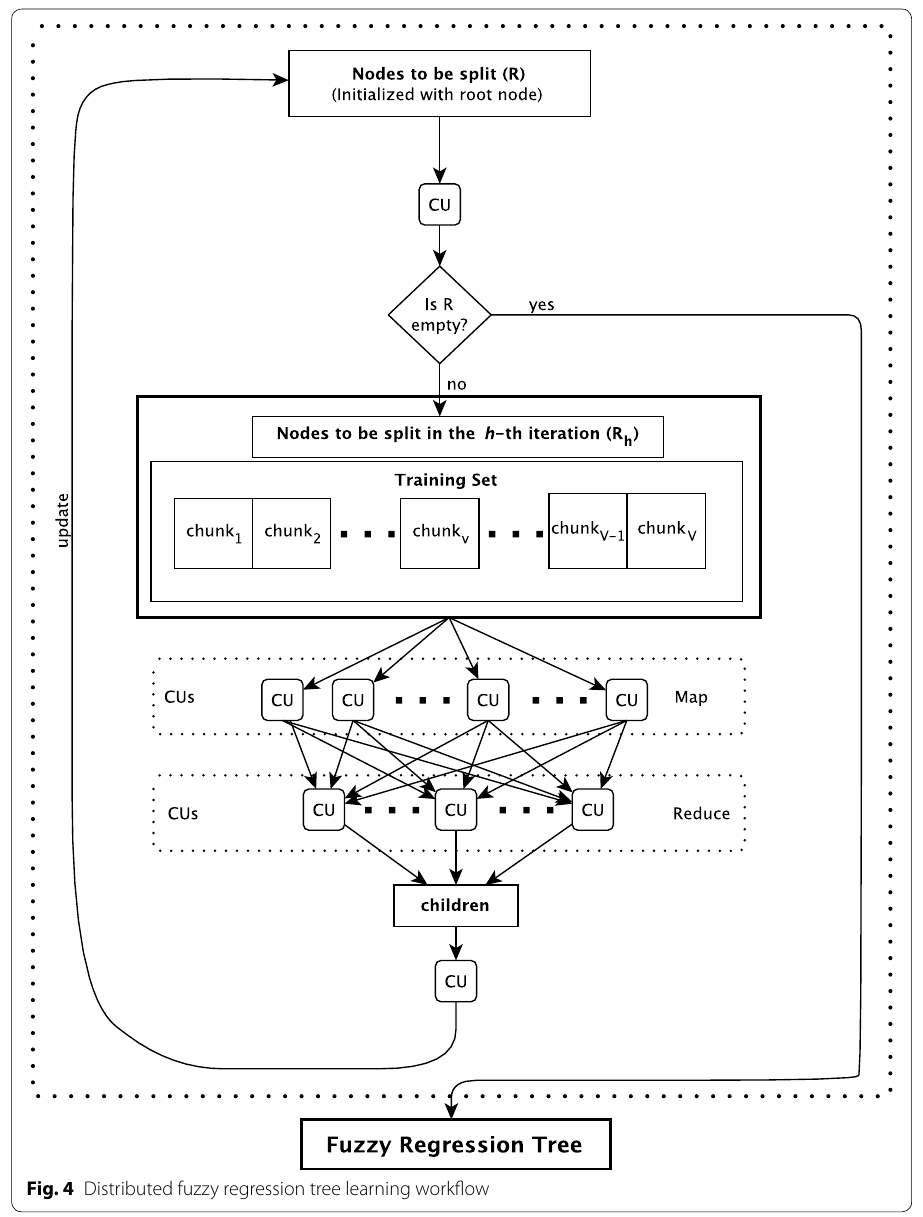
Fig. 4 Distributed fuzzy regression tree learning